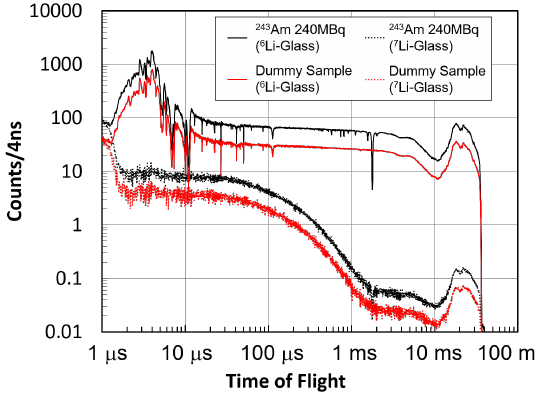
Figure 10. TOF spectra of the 243 Am and dummy samples mea- sured with the 6 Li-glass and 7 Li-glass